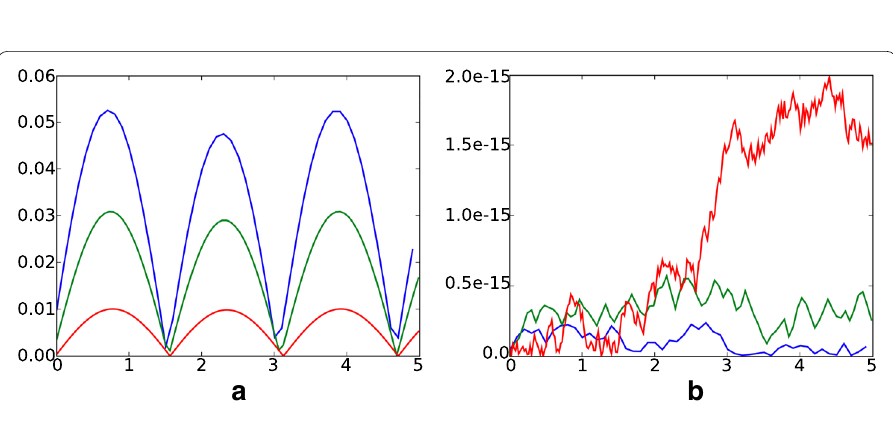
Fig. 5 Harmonic oscillator. Relative error on H with symplectic Euler-type schemes a Symplectic Euler. b Centered symplectic Euler. Blue: (cid:7) t = 0 . 1. Green: (cid:7) t = 0 . 06. Red: (cid:7) t = 0 .